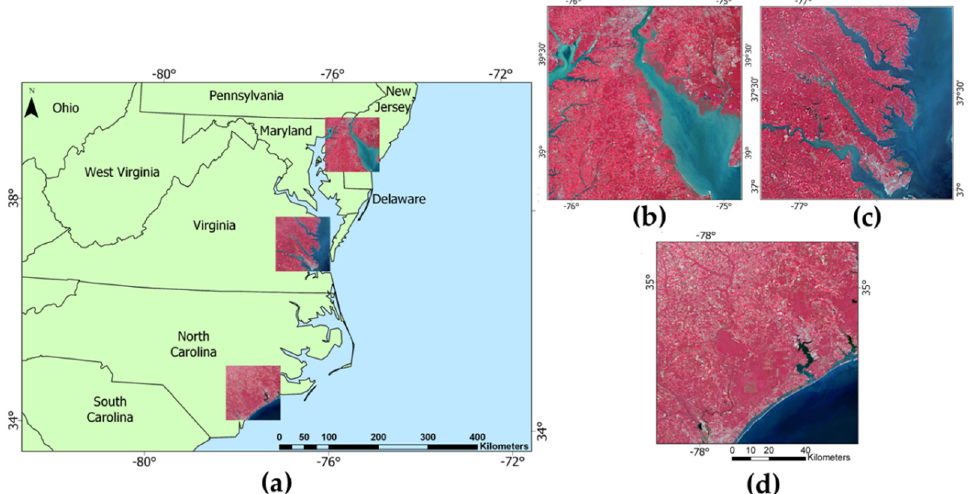
Figure 1. Study area and Sentinel-2 false color composites displaying bands NIR, red, and green, as RGB. ( a ) Study area locations. ( b ) Delaware image dataset. ( c ) Virginia image dataset. ( d ) North Carolina image dataset.